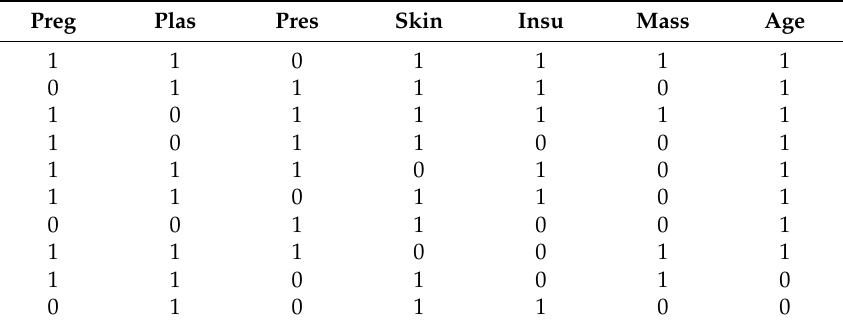
Table 17. 1-bit Mutation of the chromosome